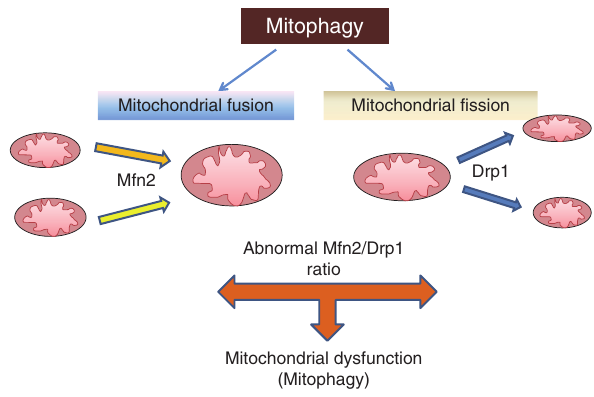
Figure 2: The role of mitochondrial fusion and fission in mitophagy. Mitochondrial fusion is promoted by Mfn2 gene, while Drp1 pro- motes mitochondrial fission. If the ratio of Mfn2 and Drp1 is altered, there is abnormal increase in the fission which leads to mitophagy. We have reported that mitochondrial division inhibitor has ben- eficial effects in pressure overload induced heart failure (63) and abnormal Mfn2/Drp1 ratio can lead to endothelial dysfunction